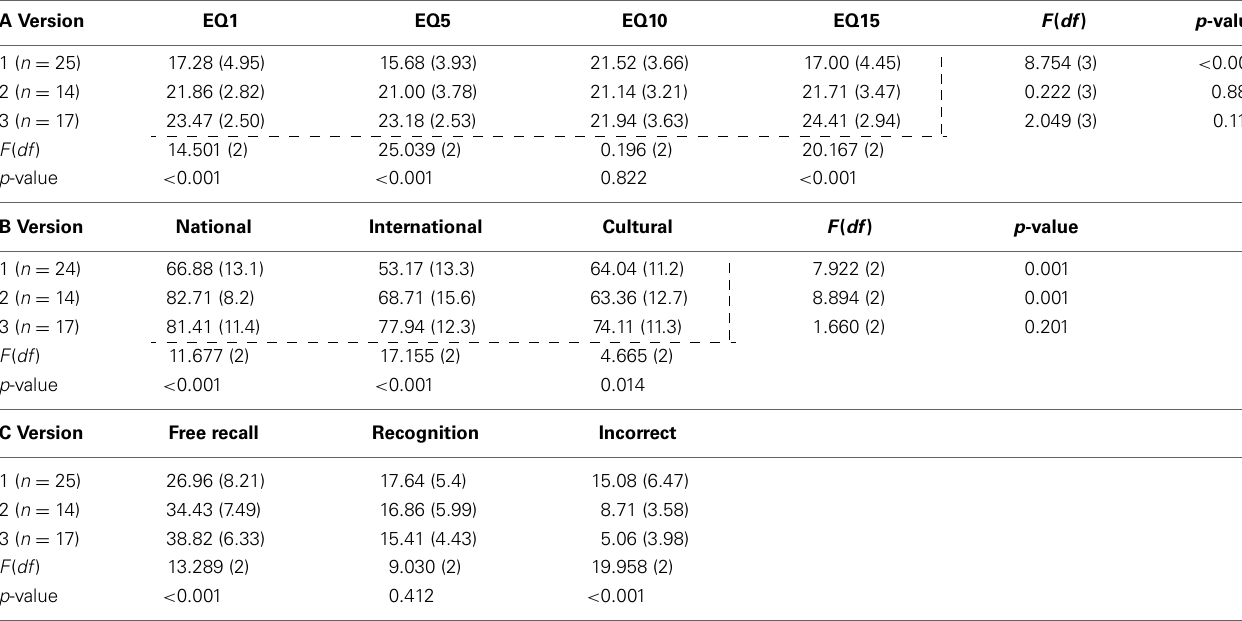
Table 2 | PEQ scores on Time-period and